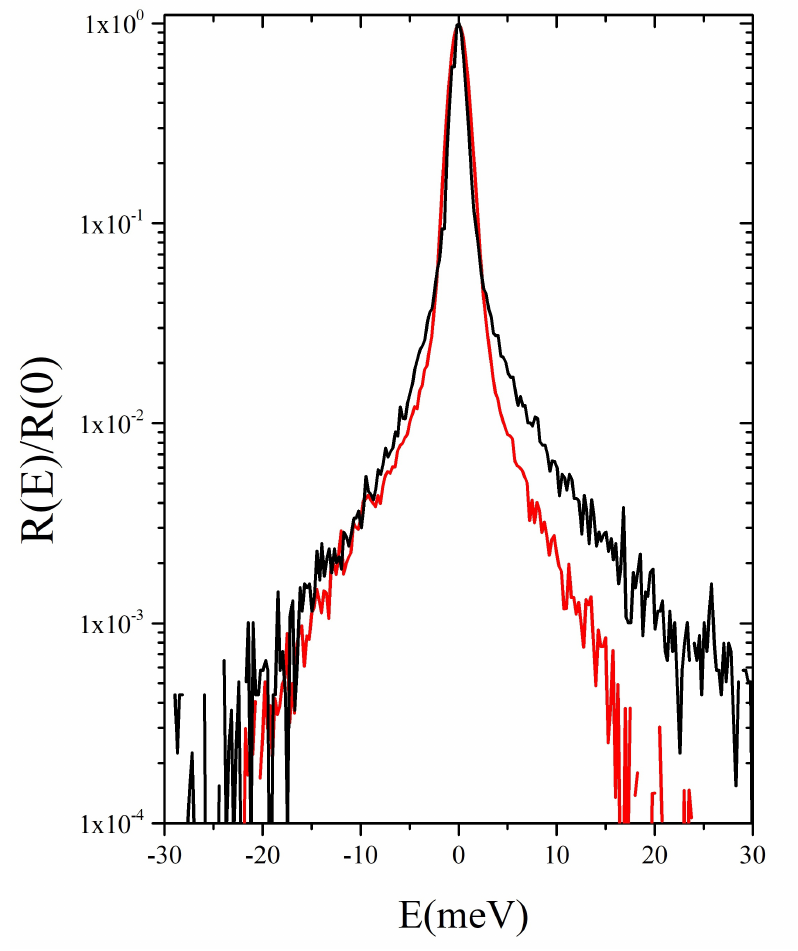
Figure 1. The instrumental energy resolution of the current measurement (red line) is here compared with that of a typical state of the art IXS spectrometer, Sector 30 at the Advanced Photon Source in Argonne National Laboratory (black line). For the sake of comparison, both resolution lineshapes R ( E ) are normalized to the respective maxima R ( 0 )